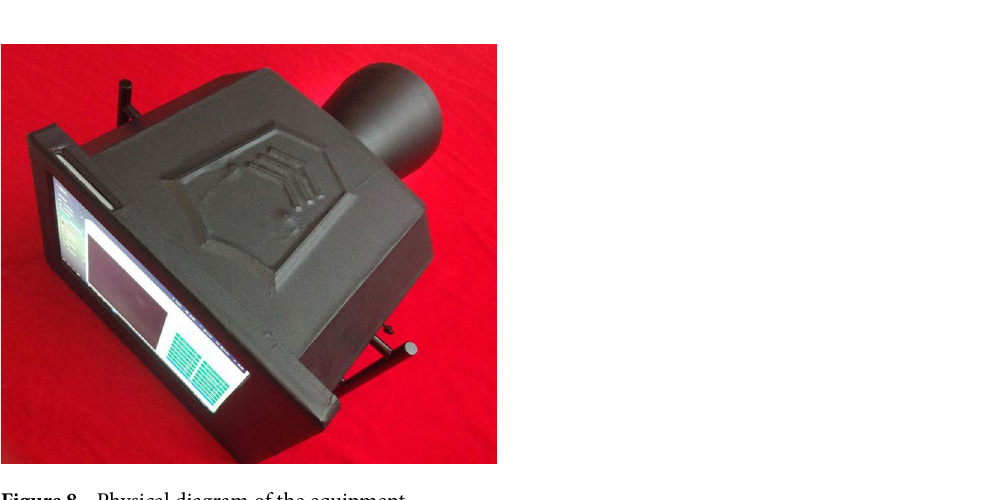
Figure 8. Physical diagram of the